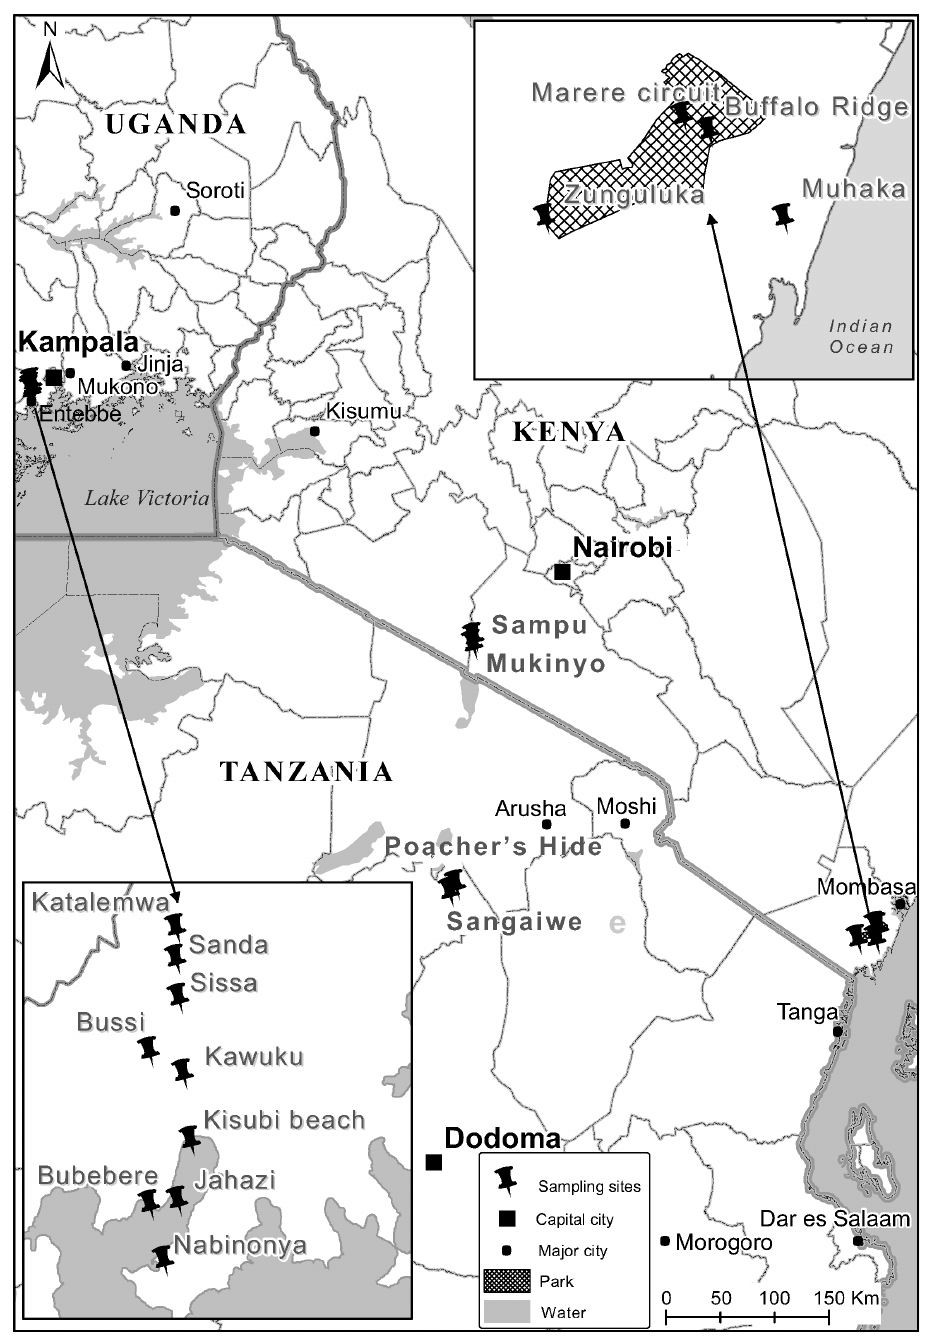
Figure 1. Fly collection sites in East Africa. In Uganda, collection sites were concentrated around the Lake Victoria basin close to swamps; in Kenya, there were two study regions one being more inland while the other was closer to the coast; in Tanzania flies were collected more